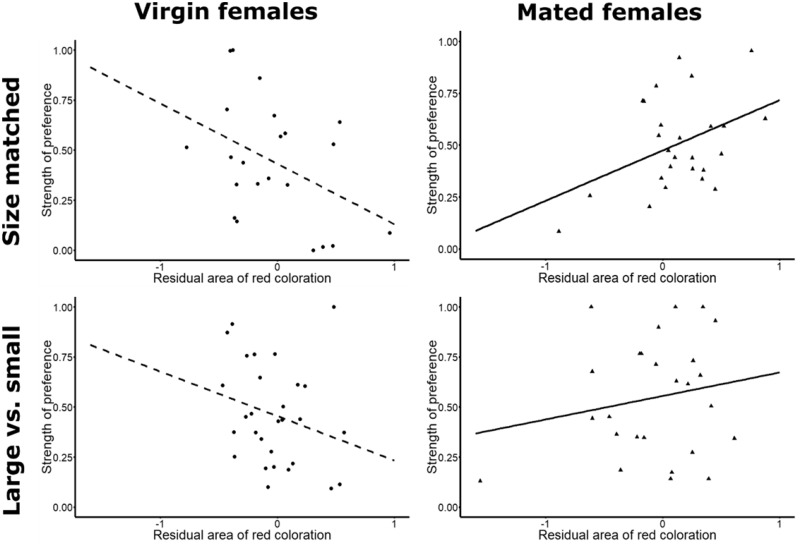
Relationship between the strength of preference of females for the left male and the area of red coloration of the left male in comparison to the right male. Y-axis: strength of preference of females for the left male. X-axis: residuals for the difference between areas of red coloration of left and right male. Residuals were obtained by constructing a linear model with the difference of red coloration of the left and right male as the dependent variable and the differences between body size, yellow coloration area, and beak size, as well as female mating status and experimental treatment as predictor variables (n = 103). For visual representation of the dataset, we divided plots according to female mating status and experimental treatment. Top: (left) virgin (n = 22, r = −0.42) and (right) mated (n = 26, r = 0.41) females choosing between 2 size-matched males. Bottom: (left) virgin (n = 29, r = −0.25) and (right) mated (n = 26, r = 0.19) females choosing between a large versus small male. Note that separated plots and indicated Pearson’s r-values are for visualization only and that the final statistical analysis presented in the “Results” section was conducted on a linear model encompassing both reproductive states and experimental treatments (n = 103).